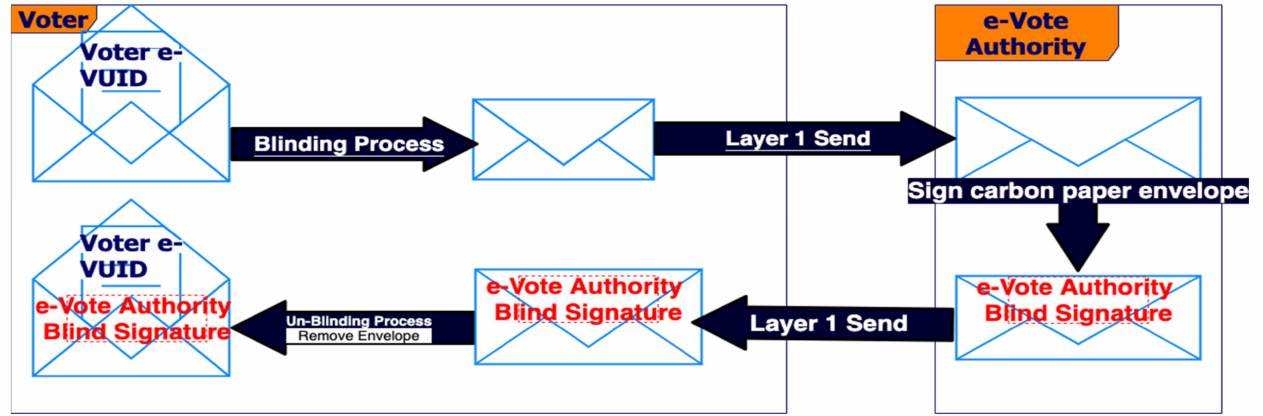
Figure 3. Blind Signature mechanism applied in Layer 1 of the e-VoteD-App